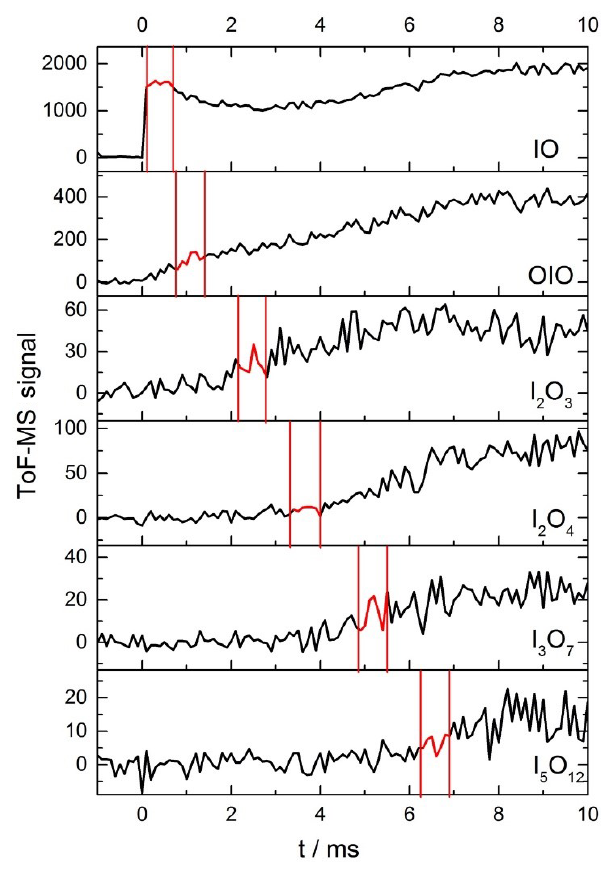
Figure 5. Time traces of IO, OIO, I 2 O 3 , I 2 O 4 , I 3 O 7 , and I 5 O 12 from − 1 to 10ms, at 1ms intervals for a mixture of He (10torr), O 3 , and I 2 ( [ O 3 ] = 4 × 10 14 molec.cm − 2 [I 2 ] = 2 . 8 × 10 14 molec.cm − 2 ) flash photolysed by an excimer pulse at t = 0 (130mJpulse − 1 ). The red sections highlighted for each species cor- respond to the optimal delay windows for photolysis of the corre- sponding species for this set of conditions.